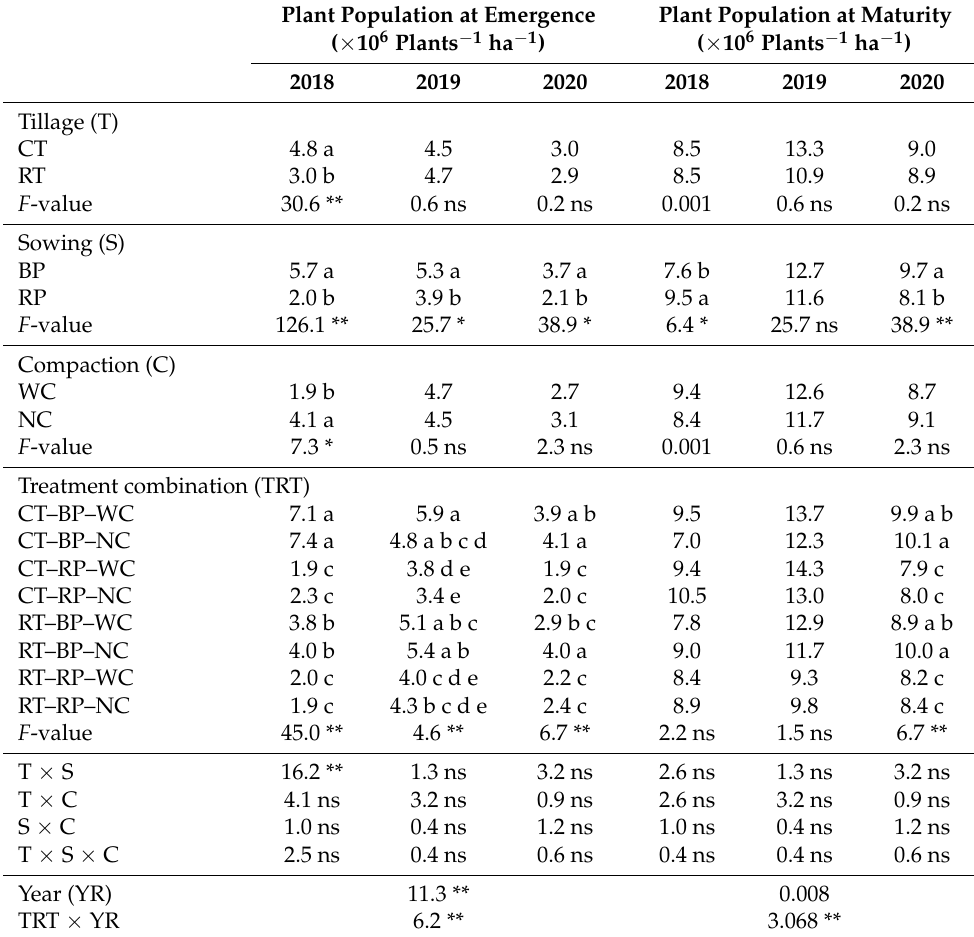
Table 4. Effects of tillage, sowing, and soil compaction methods on teff plant population at